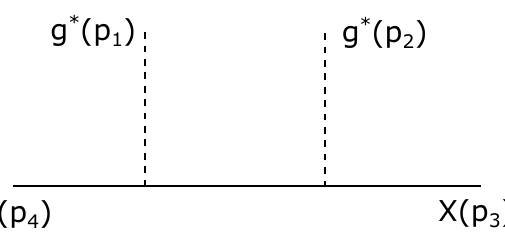
Figure 2. An elastic scattering of a probe particle and an on-shell shock state graviton. We will argue that the Regge behavior of this amplitude in consistent theories of gravity is such that gravitational shockwaves always commute. We adopt a CFT correlator-like prescription where the time in the diagram goes from right to